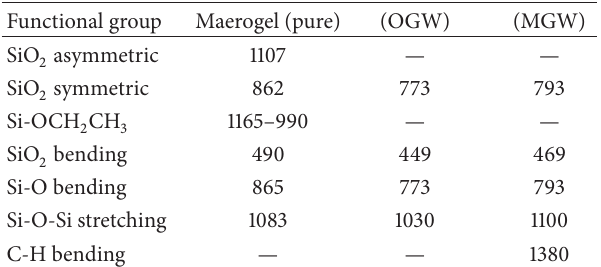
Table 2: Wavenumber assignments for the spectra of the Maerogel, OGW, and MGW